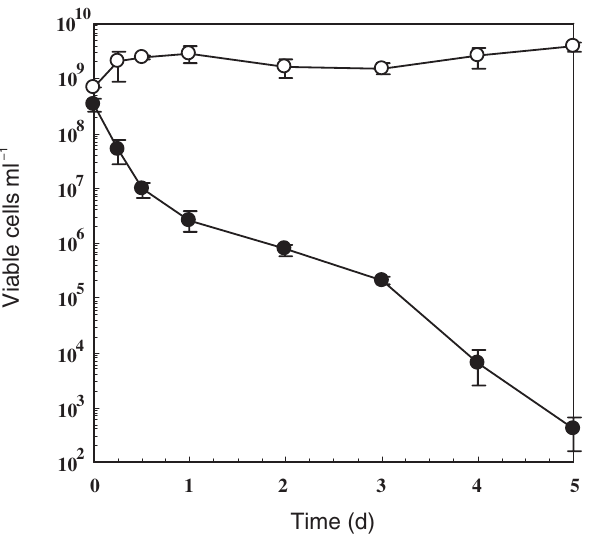
Figure 1. Survival in the absence of sulfate. Survival of F. acidar- manus in NoS medium (pH 1.0 HCl, 0.1% yeast extract) with no sul- fate ( (cid:2) ) or with 350 mM NaSO 4 ( (cid:3) ). Mean values from three independent trials are reported with error bars representing the stan- dard error of the